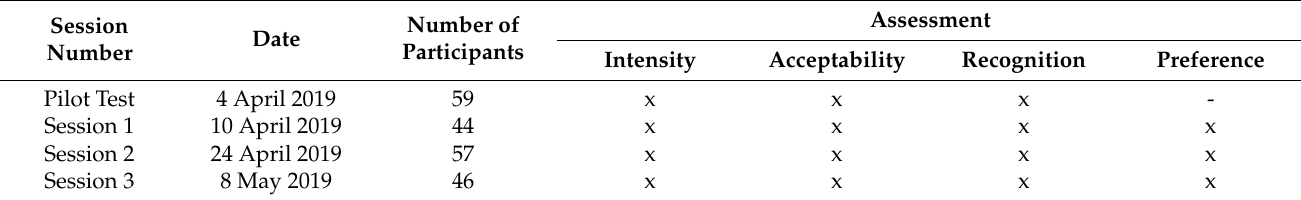
Table 1. Time schedule and